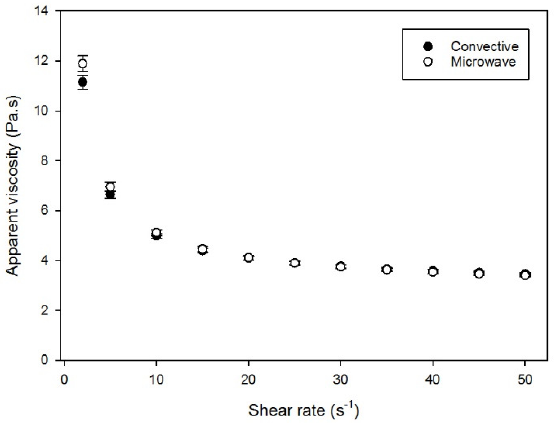
Figure 4. Viscosity (Pa.s) measured as a function of applied shear rate (s − 1 ) to compare the flow behavior of chocolate produced from convectively ( ● ) or microwave ( ○ ) roasted cocoa beans.